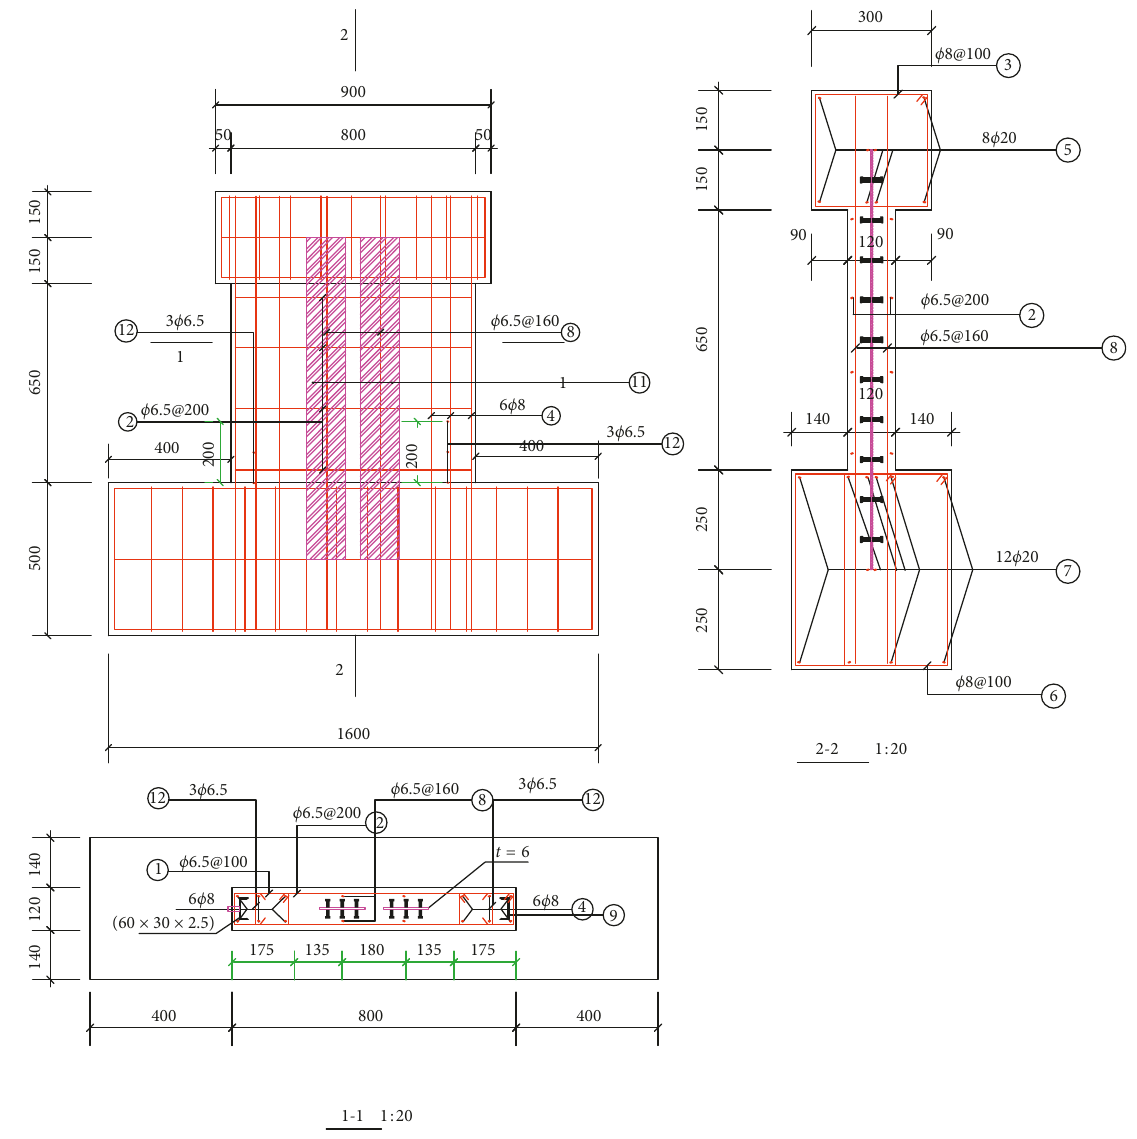
Figure 2: SPRCW-1 construction drawing. Table 2: Performance parameters of steel.